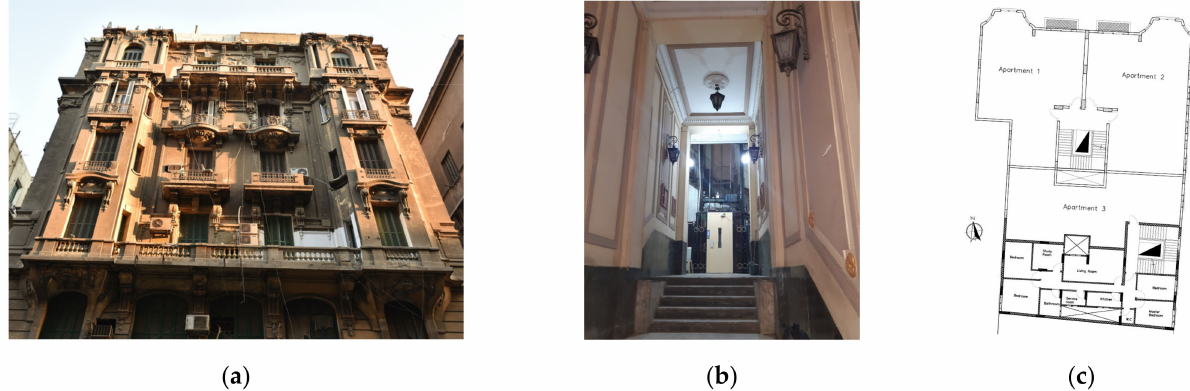
Figure 2. ( a ) Northern-west facade of the reference building; ( b ) main entrance; ( c ) typical plan of the seventh floor and the selected apartment (first author’s Ph.D.